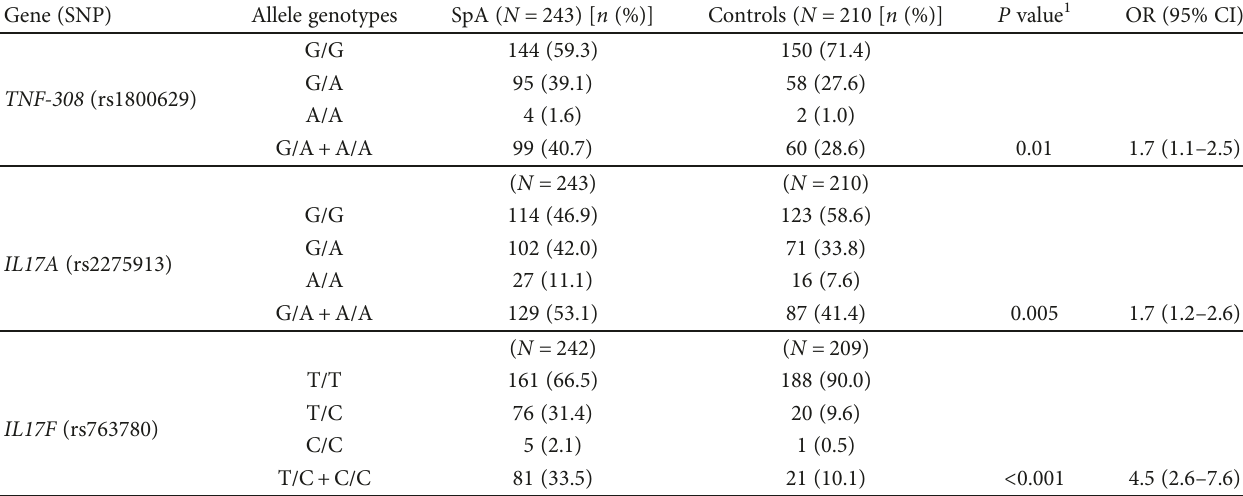
Table 3: Association of TNF-308 , IL17A , and IL17F with the risk of spondyloarthritis, strati fi ed by gender and HLA-B27 marker. Gene (SNP) Allele genotypes